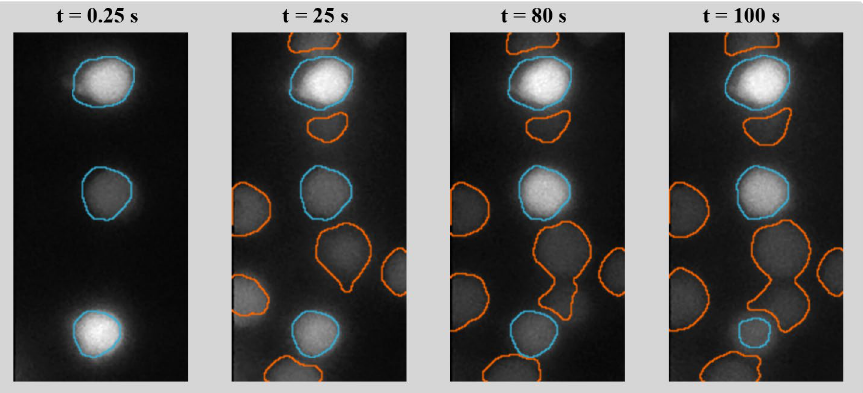
Figure 7. Boundaries of segmented Jurkat T-cells (blue) and anti-body coated beads (orange) in four frames of Fluo-4 Ca 2 + imaging data, computed by the proposed RC model with encoding scheme 2. Despite cellular and beads movement and significant local and temporal variation of fluorescence intensity, the algorithm provides a robust and efficient solution to the task [Graphics created with MATLAB and the Image Processing Toolbox Release 2019b, The MathWorks, Inc. (http:// mathw orks. com/ produ cts/ image.